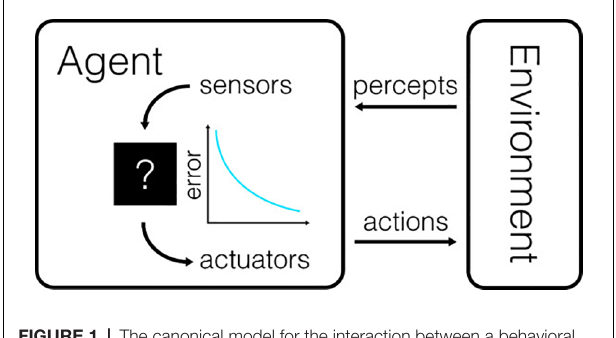
FIGURE 1 | The canonical model for the interaction between a behavioral subject and its environment. The agent receives information about the state of the environment through a variety of sensors and can control the state of the environment through the use of actuators. Actions are chosen to minimize the difference between the perceived state of the world and the intended state of the world. The amount by which this difference is reduced is also sometimes referred to as the utility of an